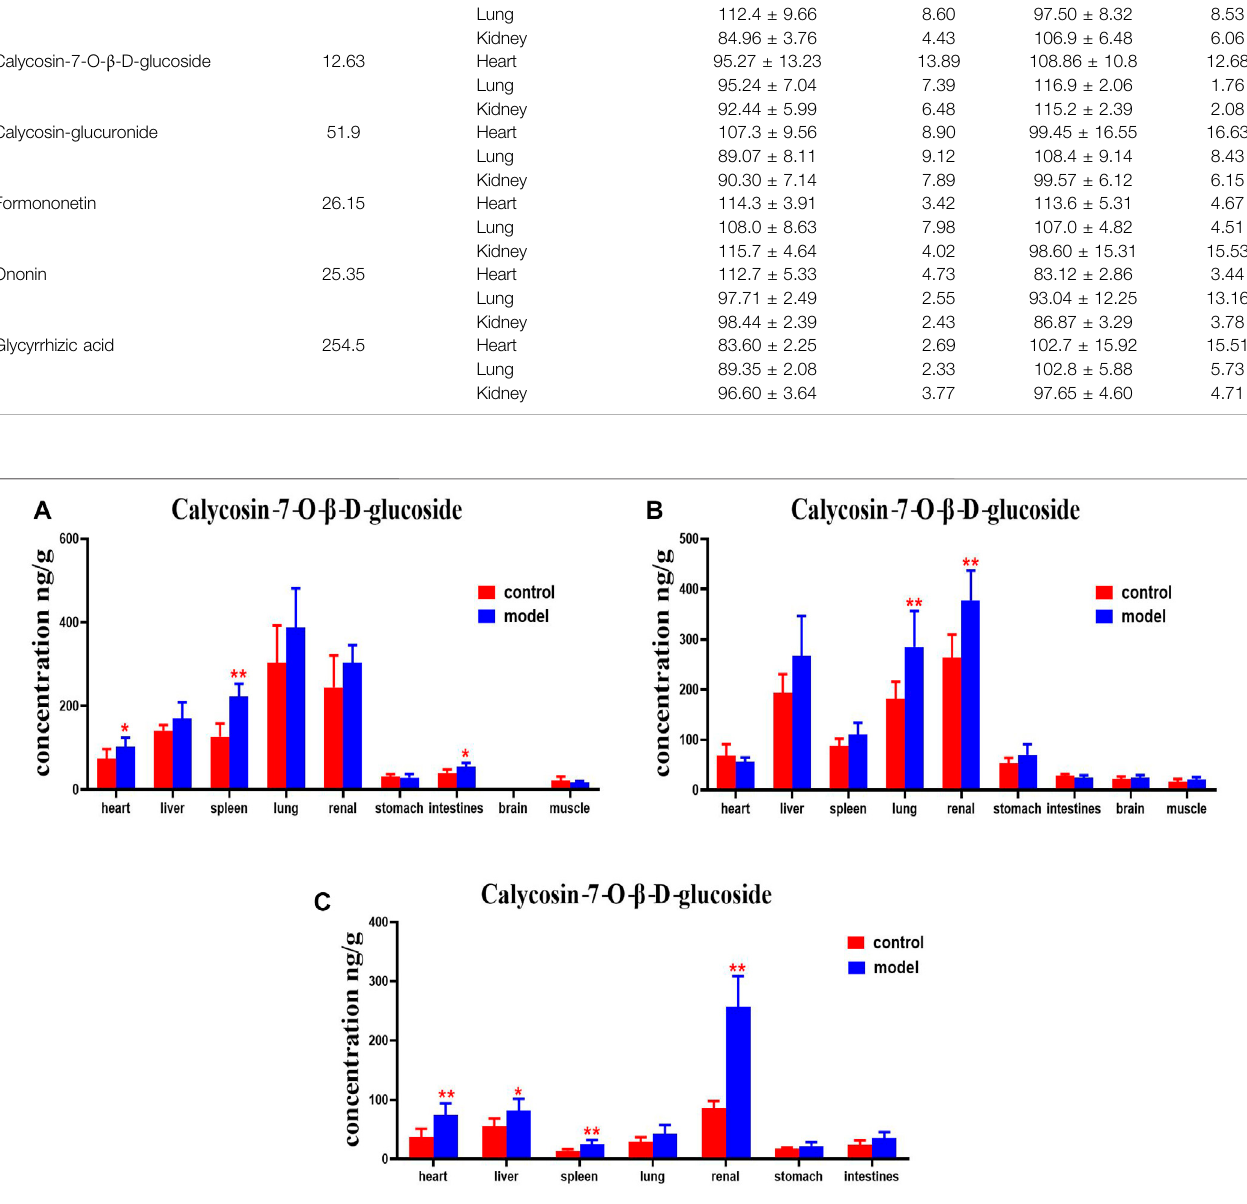
Frontiers in Pharmacology |